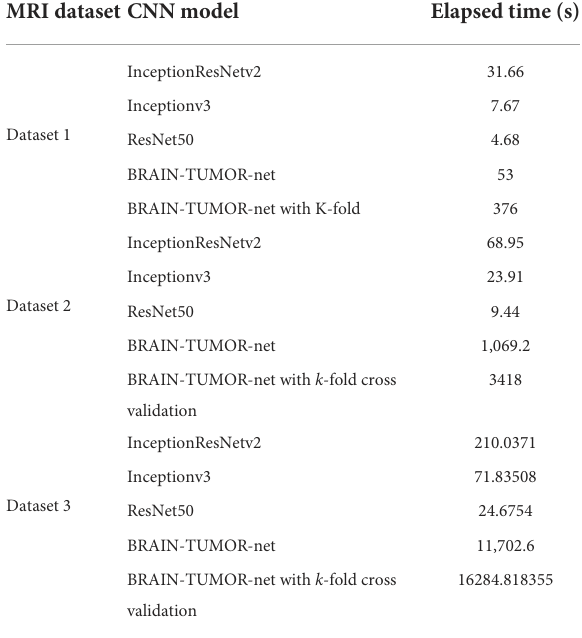
TABLE 5 Computational times of the examined